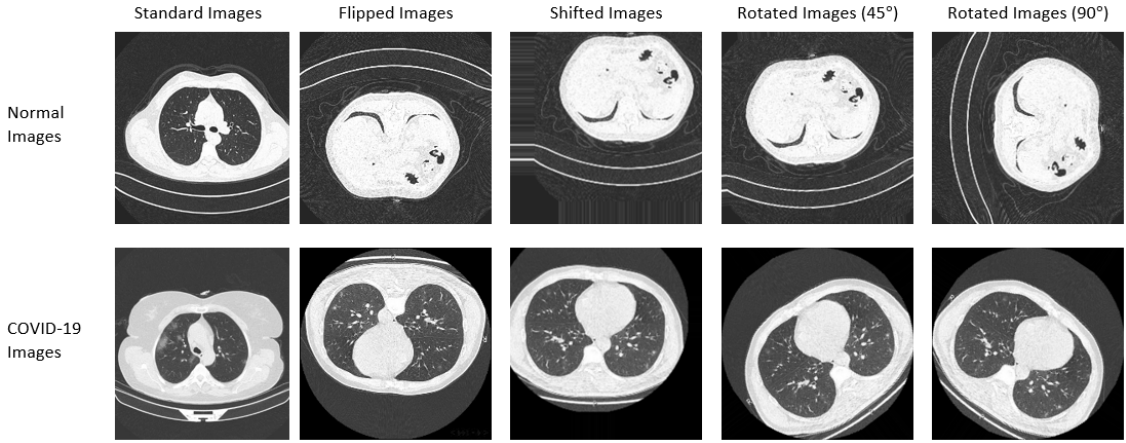
Figure 2. Samples of standard and augmented CT images used for